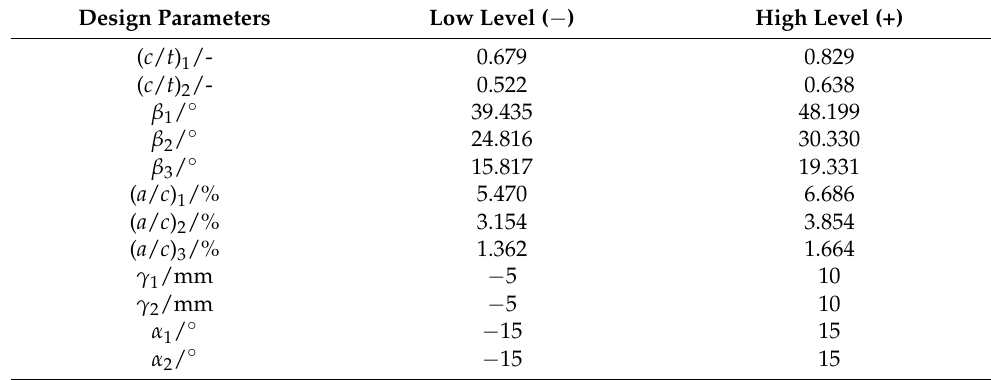
Table 2. Range of design parameters.